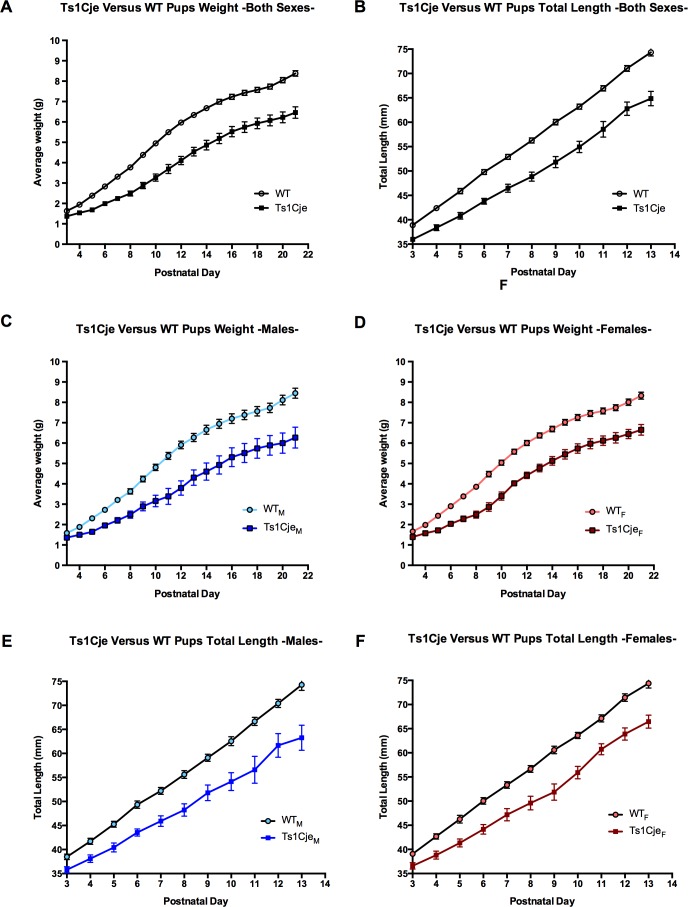
Pre-weaning growth profile of the Ts1Cje and WT neonates.Body weight and length were measured on a daily basis and compared between Ts1Cje and WT littermates. Ts1Cje neonates were consistently lighter and smaller than WT neonates (A-B). Sex stratified analyses revealed that both Ts1Cje males and females showed growth delays compared to their sex-matched WT littermates (C-E). Data are represented as mean ± SEM.